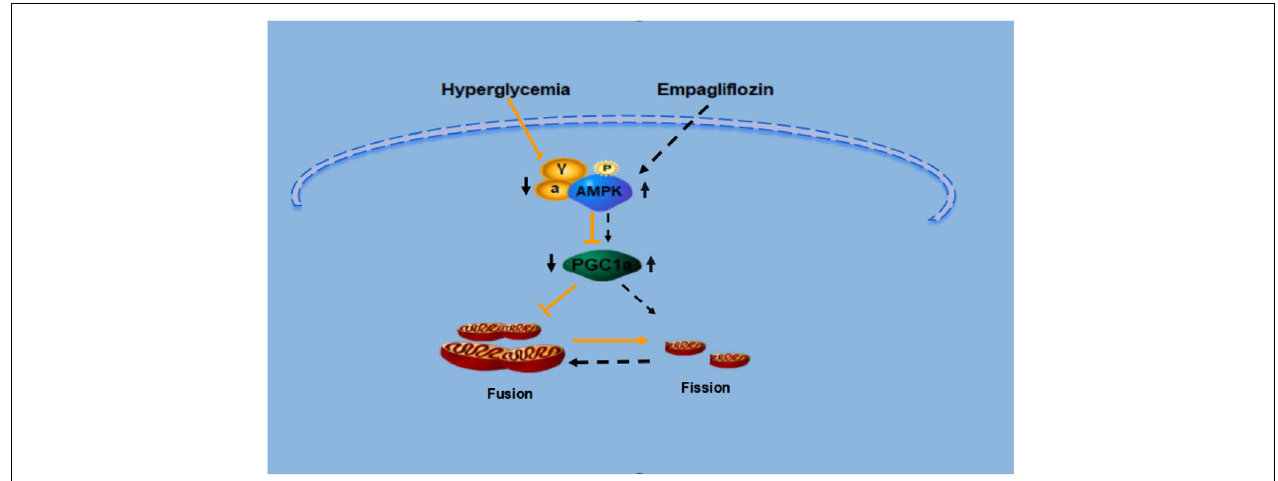
FIGURE 8 | Proposed model for the signaling pathway by which empagliflozin induces white adipocyte browning and modulates mitochondrial dynamics via an AMPK dependent